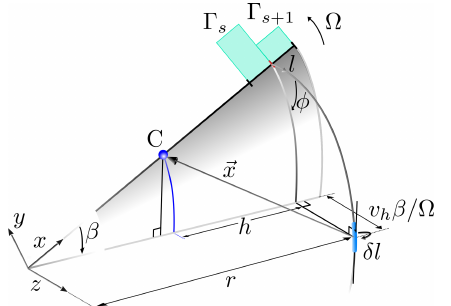
Figure 4. Trailed vorticity path. The blade rotates in the x − y plane and z points downstream. The vortex element δl with a strength of (cid:48) s − (cid:48) s + 1 is shed at r and transported downstream by the local velocity. The distance from the shedding location r to a point C along the blade is h ( h = r − C x ), where δl induces tangential and axial